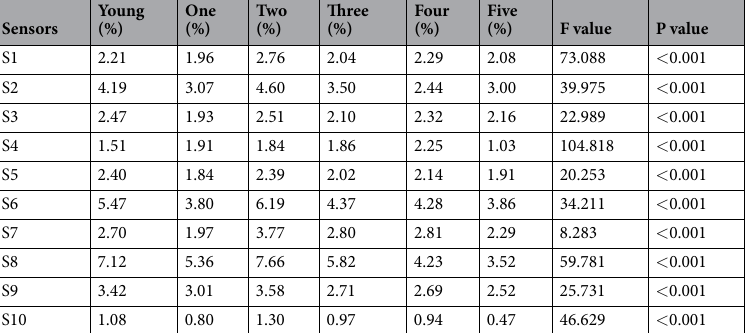
Table 2. Results of RSD test and One Way ANOVA of response values. Each RSD value was obtained from 20 samples of each group. One Way ANOVA of each sensor was performed with 120 samples (20 replicates multiply by 6